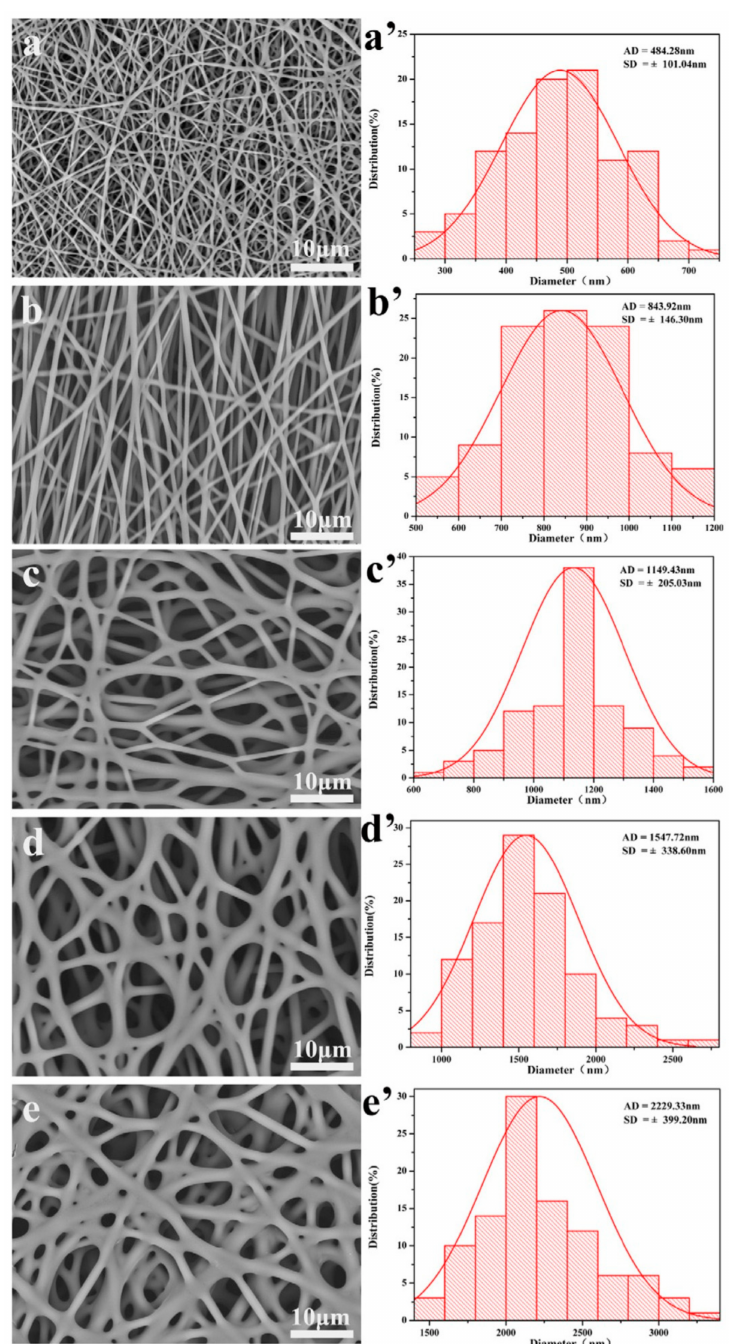
Figure 4. Honey increases fiber diameter. SEM images and histograms of fiber diameters of silk/PEO nanofibrous matrices spun with ( a , a’ ) no Manukah honey; ( b , b’ ) 10% w / v Manuka honey; ( c , c’ ) 30% w / v Manuka honey; ( d , d’ ) 50% w / v Manuka honey; and ( e , e’ ) 70% w / v Manuka honey. Reproduced with permission from Yang et al., Materials & Design ; published by Elsevier,